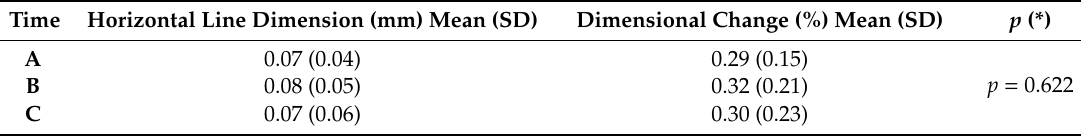
Table 1. Descriptive and statistical analysis.